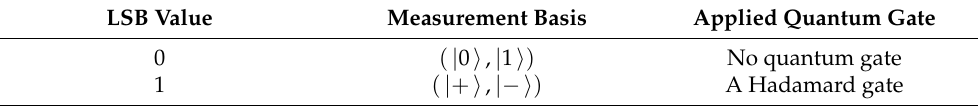
Table 1. The correspondence between the LSB value of the gray intensity for the selected pixels in the images sent by Alice and Bob to the server, measurement basis, and applied quantum gate in the circuit created by the